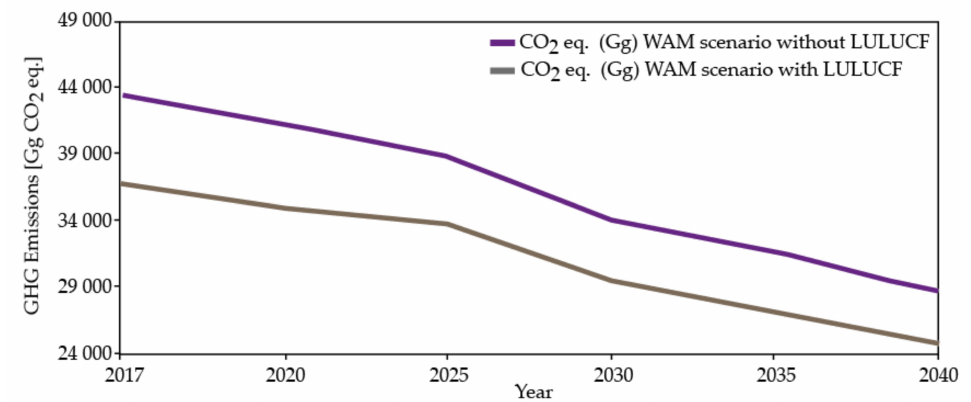
Figure 12. The projection of emissions according to the WAM scenario [73].